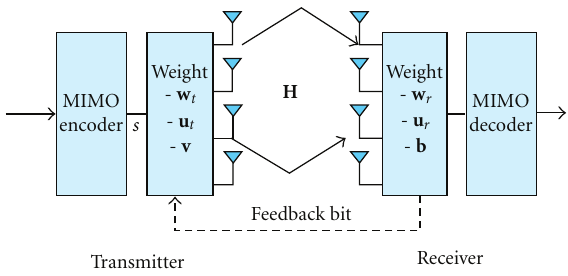
Figure 1: 4 × 4 MIMO system with